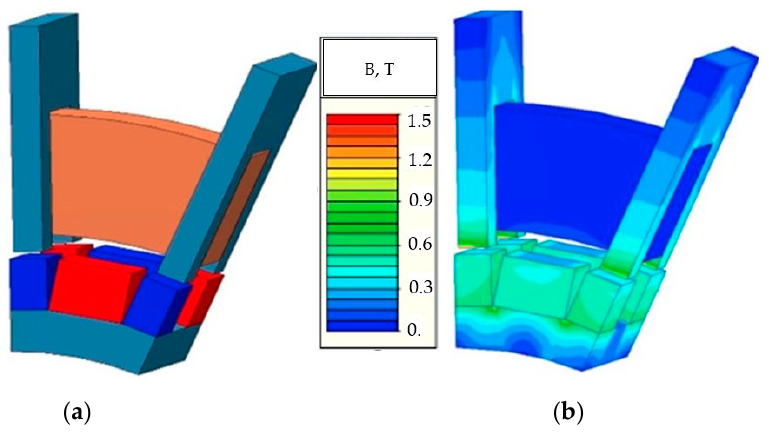
Figure 2. Computer model of the TFM segment: ( a ) 3D FEM model of the segment and ( b ) magnetic flux density distribution in the segment.